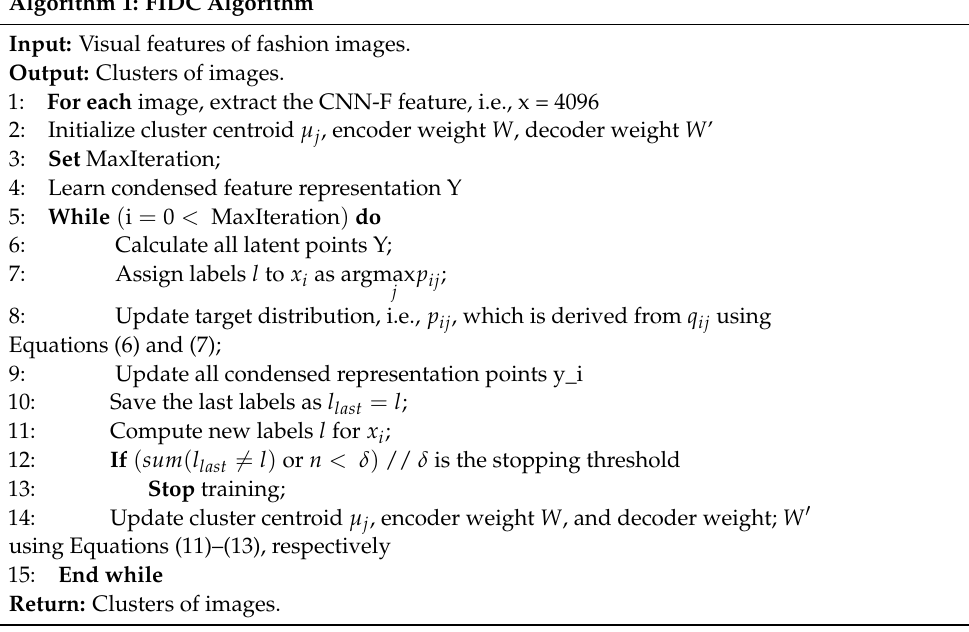
Algorithm 1: FIDC